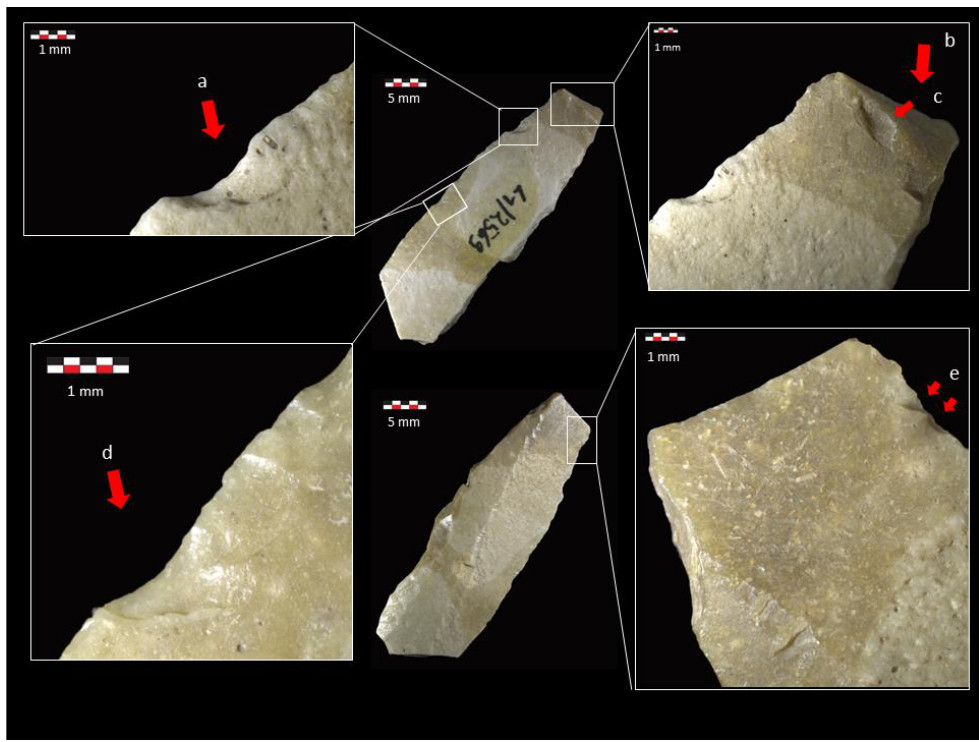
Figure 11. Macroscopic details of the impact damage present on the curved backed piece L12569 identified as a projectile. The piece presents a combination of damage features: a)+d)+e) oriented lateral scarring; b) bending breaks and; c) secondary damage.